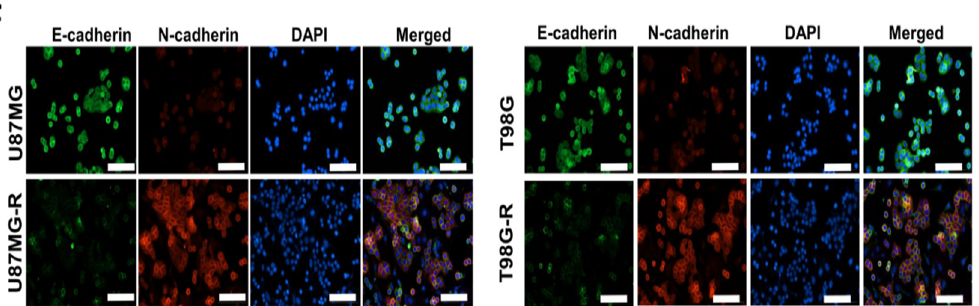
Figure 3. USP6NL is markedly expressed in TMZ resistant cells with high stemness phenotypes ( A – C ) Representative image of colony-forming (self-renewal ability), tumor initiation (sphere assay), and migratory/invasive properties of TMZ-resistant GBM cells (U87MG-R and T98G-R). Scale bar: 100 µ m. ( D , E ) Western blot and qRT-PCR results of the expression of USP6NL and key CSC’s markers associated with therapy resistance. ( F ) EMT processes in TMZ-resistant GBM (U87MG-R and T98G-R) cells were also examined through IF analysis of E-cadherin and N-cadherin staining. Scale bar: 10 µ m. *** p < 0.001.